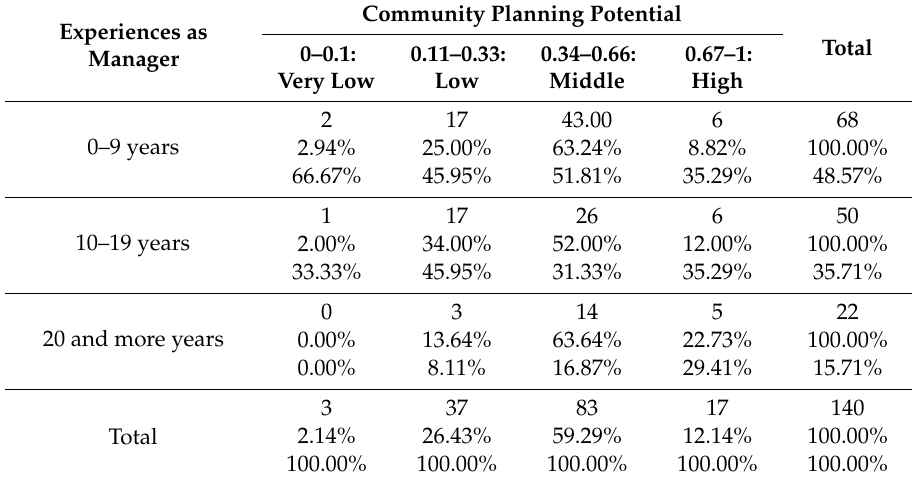
Table 9. Experiences as Manager × Community Planning Potential (count, row %, column %, total %). Experiences as